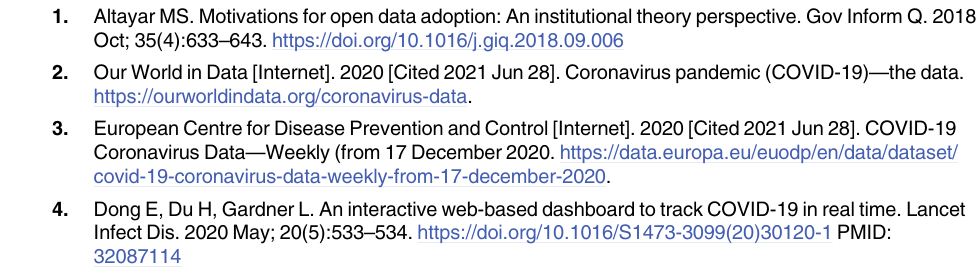
S1 Table. Content of public open datasets on COVID-19 in the Czech Republic. S2 Table. Content of datasets on COVID-19 in the Czech Republic for predictive model- ling. S3 Table. Content of regional datasets on COVID-19 in the Czech Republic for local authorities and regional disease